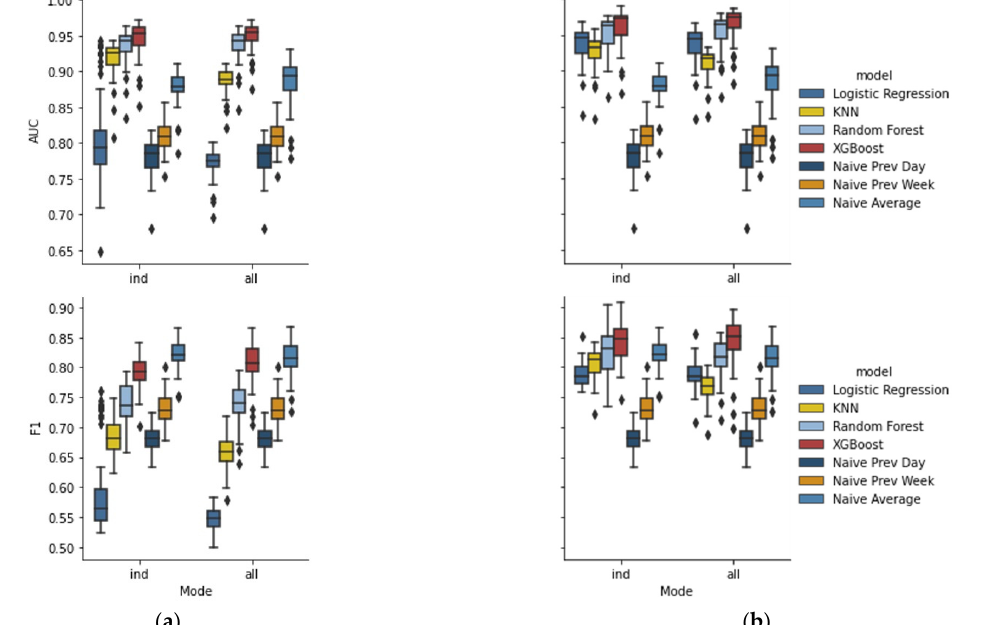
Figure 6. ( a ) AUC and F1 score for the different models and modes at JPL for standard feature set; ( b ) AUC and F1 score for the different models and modes at JPL for augmented feature set.